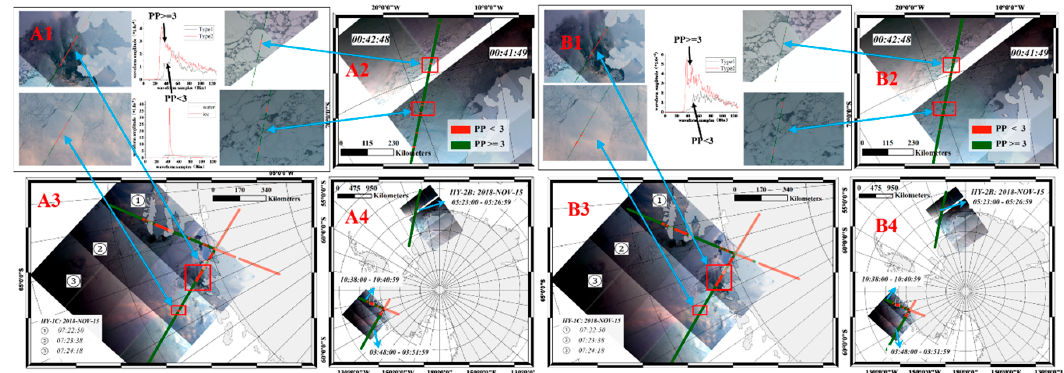
Figure 11. Distributions of the classifications of the PP values of the HY-2B ALT data. Note: A1 — A4 indicate the Ku Band; B1 — B4 indicate the C Ban d.